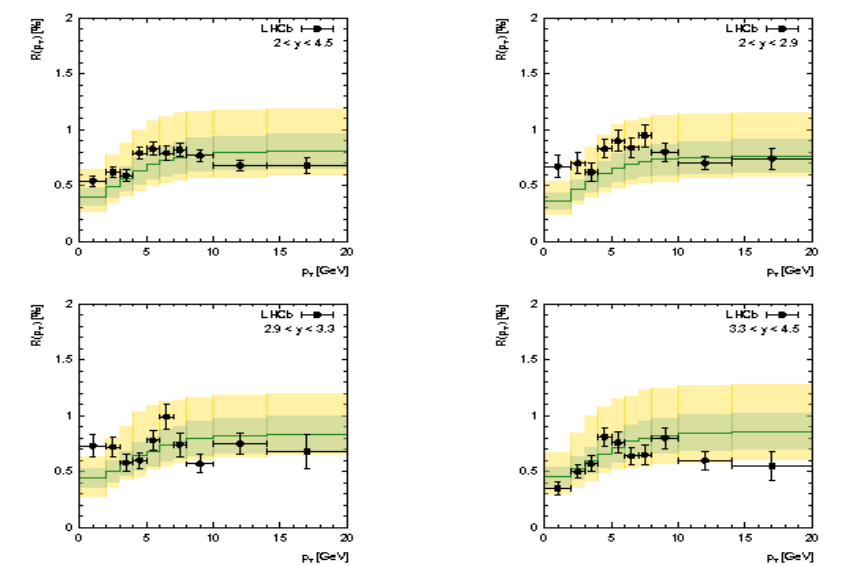
Figure 1. The ratio of the B ( ∗ ) c to B + production cross sections (13) as a function of the transverse mo- mentum for three di ff erent rapidity intervals. Green histograms correspond to the conventional choice α 4 ( m 2 ). Grey band indicates the statistical uncertainty in the determination of the B ( ∗ ) c radial wave S B c T function; yellow band represents uncertainties coming from the renormalization scale. The histograms α 2 reflect the replacement α 4 ( m 2 ) ( m 2 ) α 2 ( m 2 ). Experimental points are from Ref. S B c T S B c T S cT →